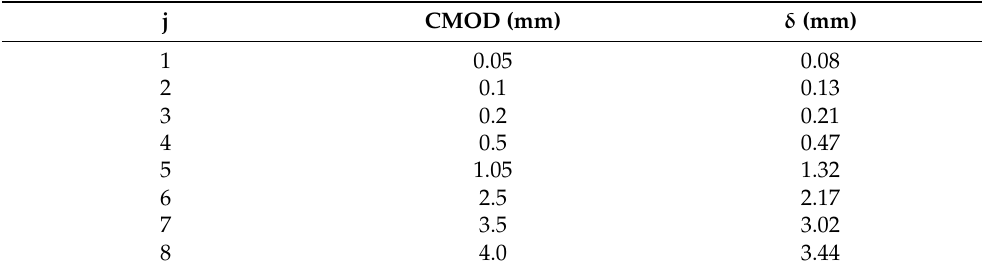
Table 5. Correlation between CMOD and deflection